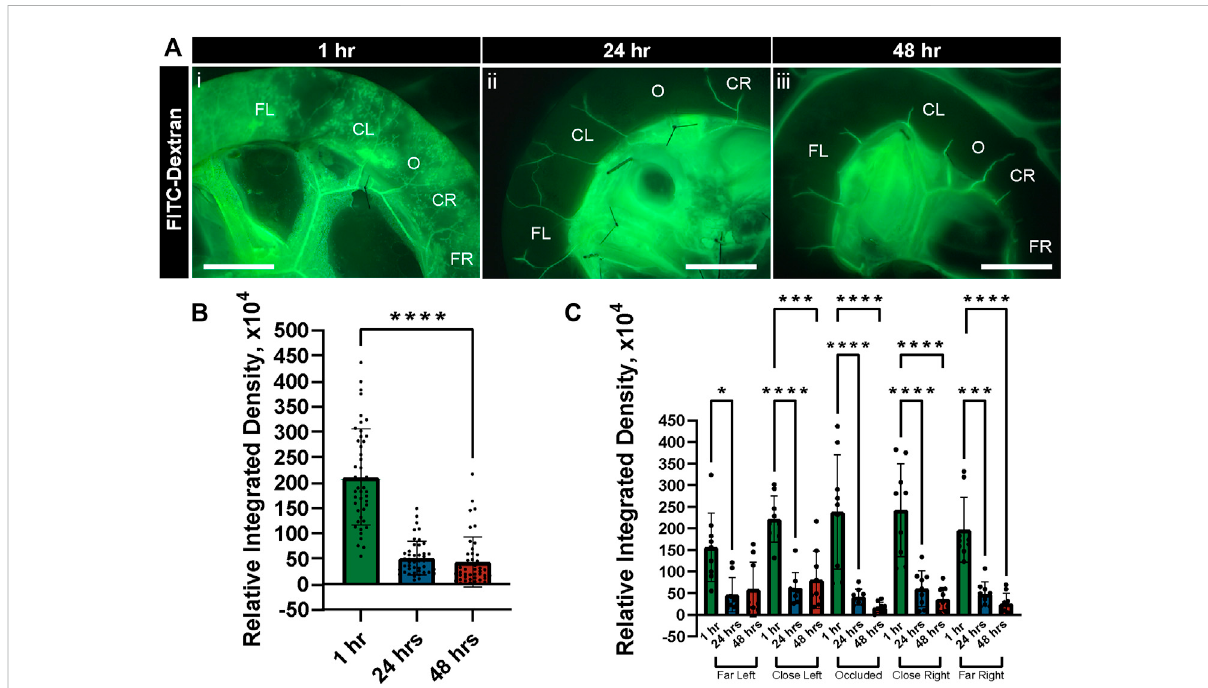
FITC-Dextran Perfusion in Intestinal Vasculature Decreases after Culture in Controlled Flow Conditions. (A) Representative images of FITC- Dextran (green in i-iii) following perfusion through the intestinal vasculature after 1 h (i), 24 h (ii), and 48 h (iii) of tissue culture with controlled fl ow. Regions are labeled as to their location relative to the occlusion site (O), with more distal areas labeled as Far Left (FL) and Far Right (FR) and more proximal areas as Close Left (CL) and Close Right (CR). Scale bars in each image (i-iii) are 1 cm. (B) Relative integrated densities of FITC-Dextran quanti fi ed in tissue after 1 h (green bar), 24 h (blue bar), and 48 h (red bar) of culture with controlled fl ow. Error bars represent ± standard deviation. **** p ≤ 0.0001 for 1 h vs. 24 h and 48 h. (C) Relative integrated densities of FITC-Dextran quanti fi ed in tissue after 1 h (green bars), 24 h (blue bars), and 48 h (red bars) of culture with controlled fl ow, disaggregated by region. Error bars represent ± standard deviation. * p ≤ 0.05, *** p ≤ 0.001, and **** p ≤ 0.0001 for the comparisons denoted. Biological replicates for this experiment were at a minimum of n = 3, and data points shown are from technical replicates across all